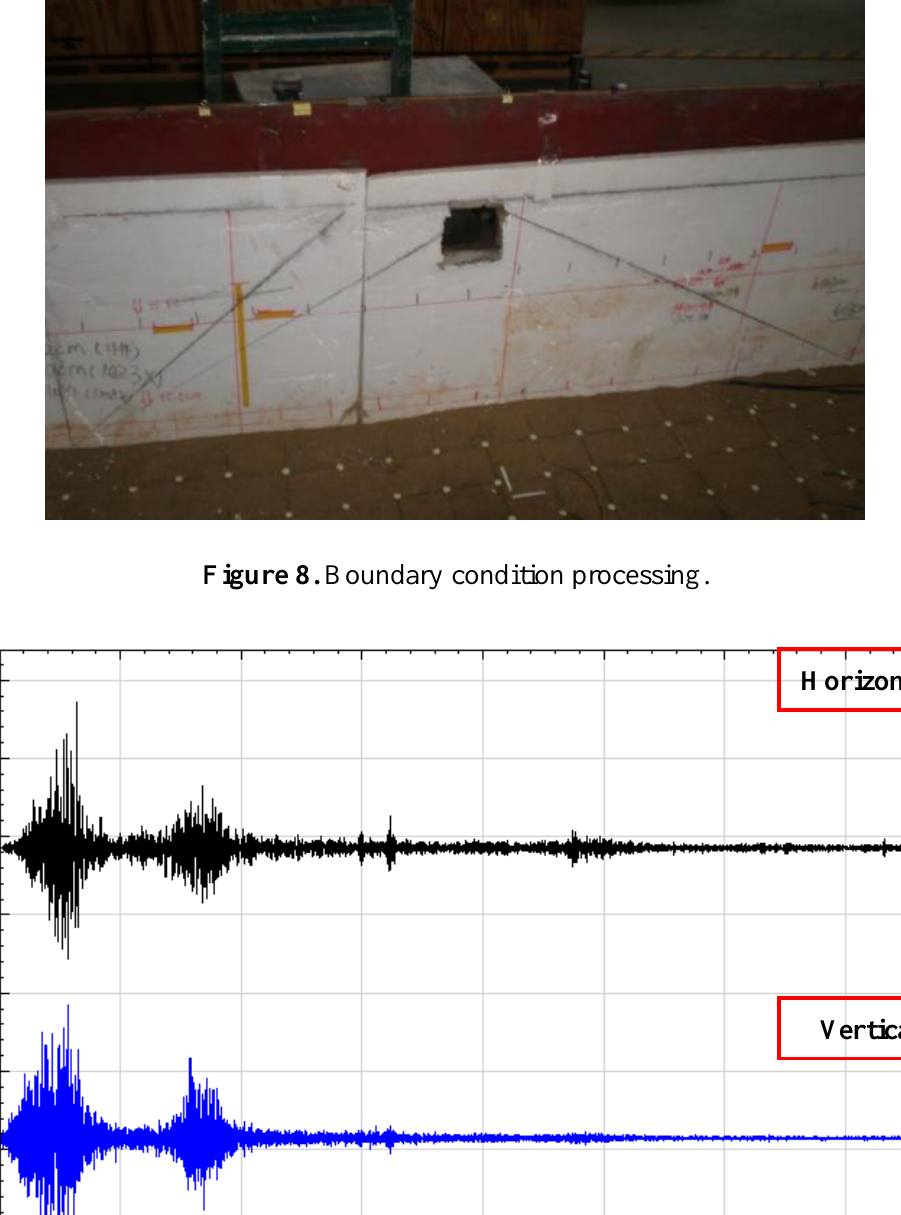
Figure 9. Time history of horizontal and vertical acceleration.